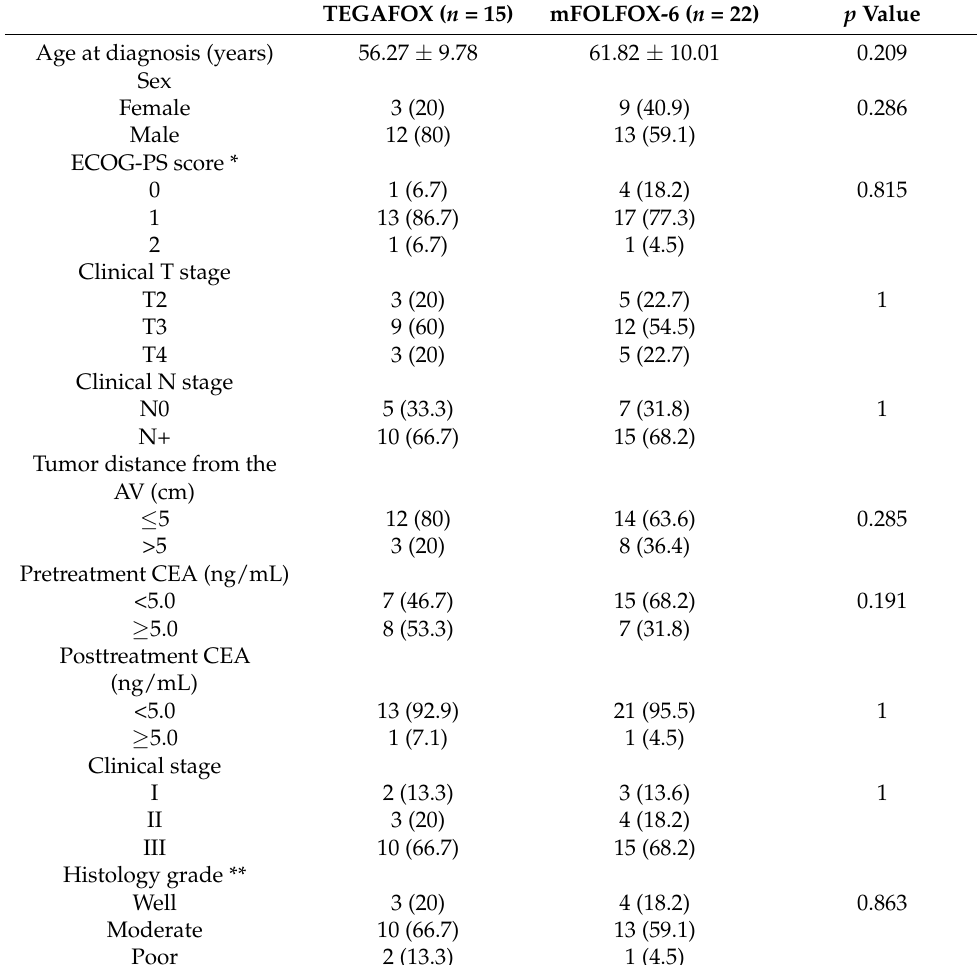
Table 1. Patient characteristics by chemotherapy